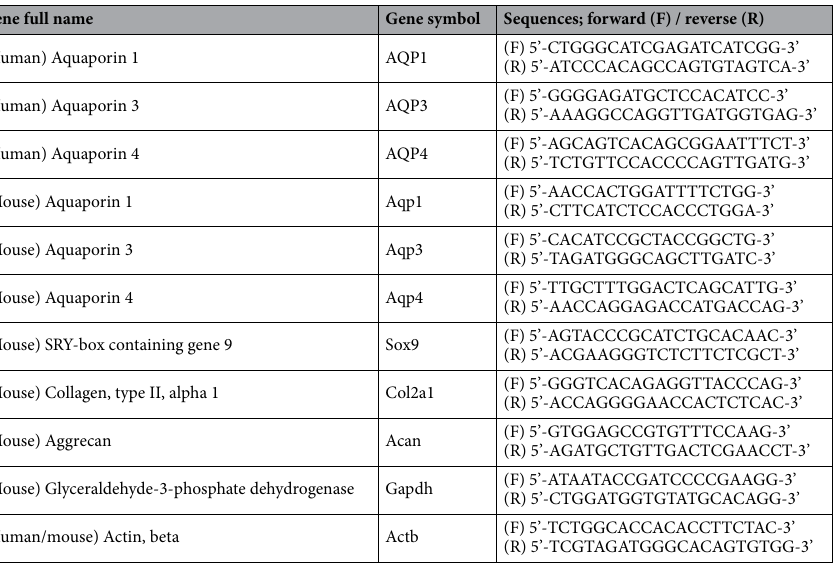
Table 1. Primers used for quantitative